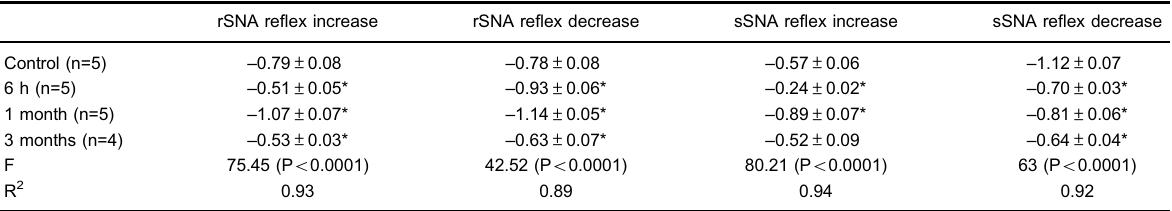
Table 2. Barore fl ex assessed by changes in renal and splanchnic sympathetic vasomotor activity (rSNA and sSNA, respectively) in response to mean arterial pressure variations induced by systemic administration of vasoactive drugs in the control and sepsis groups at different